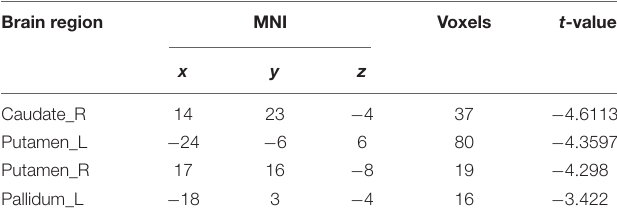
TABLE 2 | Brain regions with altered ReHo in iRBD patients compared to control groups. Brain